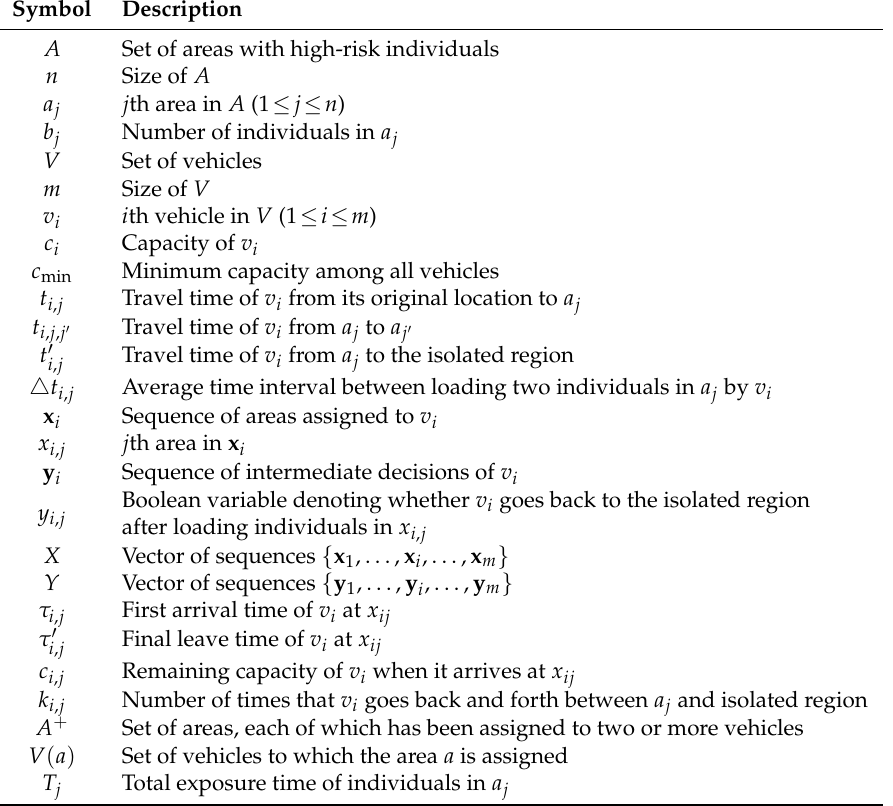
Table 1. Mathematical variables used in the problem